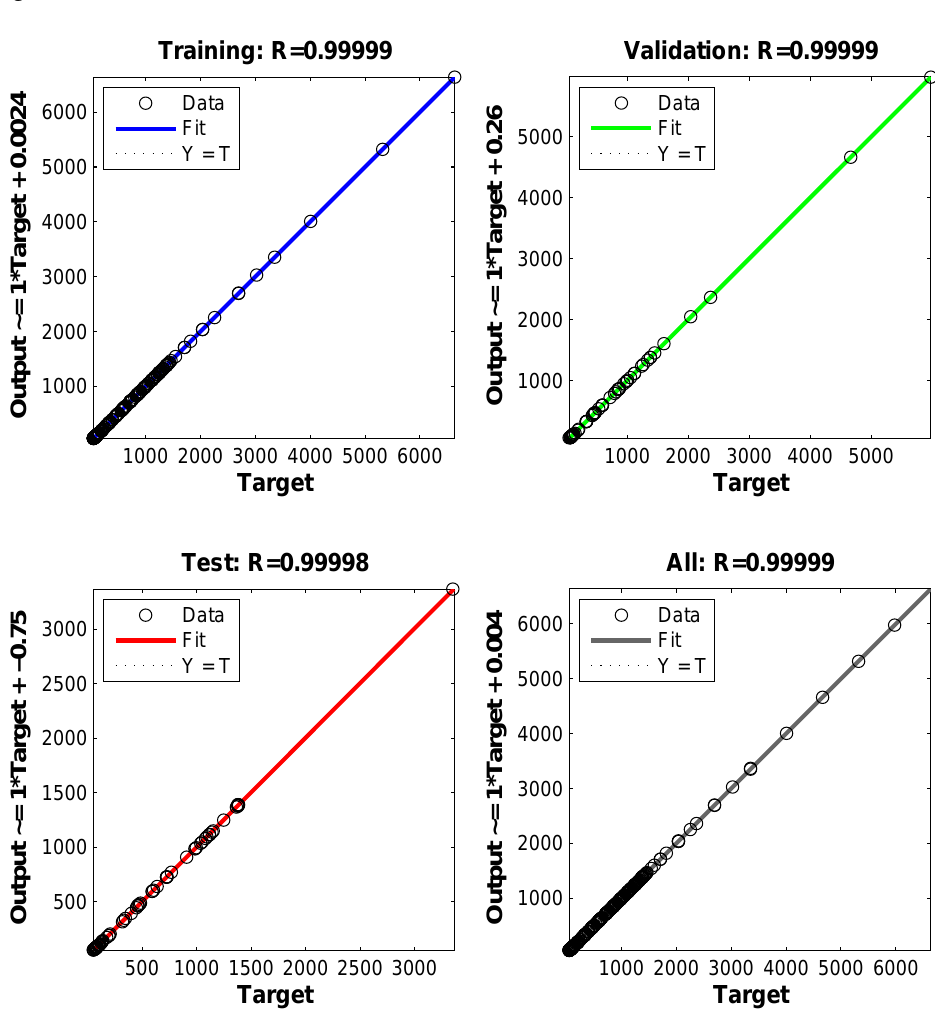
Figure 4. Regression plots for training, validation, and testing; the targets are simulated data and the outputs are ANN-predicted